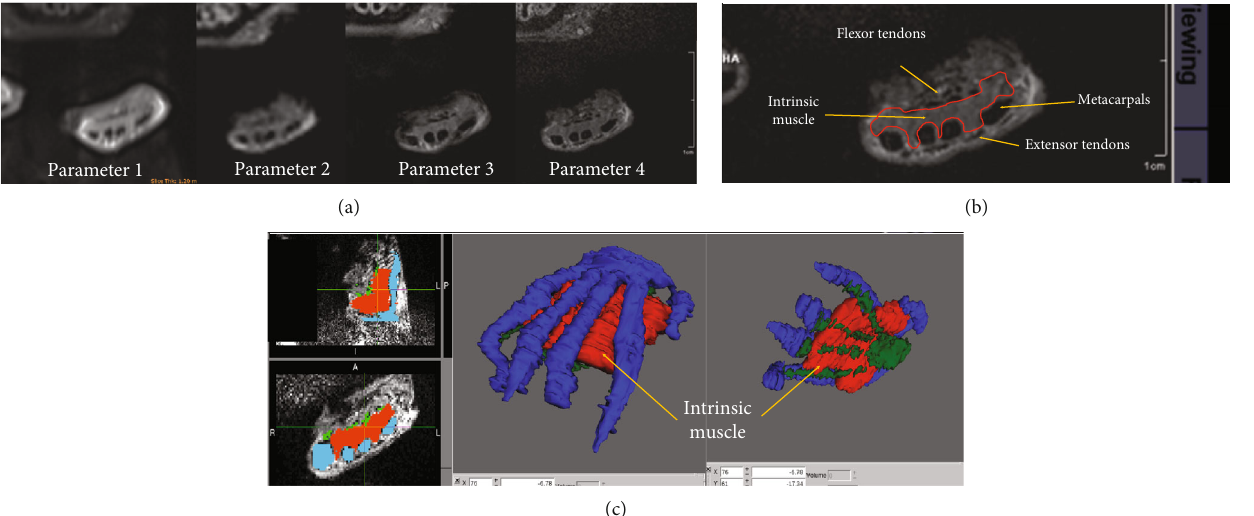
Figure 3: Establishing the MR imaging paradigm to assess the paw intrinsic muscle volume. (a) To determine the best imaging protocol, we compare the imaging quality of the four parameters speci fi ed in Table 1. Readers were asked to report their con fi dence in the manual segmentation of the intrinsic muscle, which was contoured by the metacarpal bone and the fl exor/extensor tendons (b). (c) Finally, manual segmentation of the intrinsic muscle (red voxels) based on parameter 4 was taken as the fi nal setup for muscle volumetry of the subsequent study.